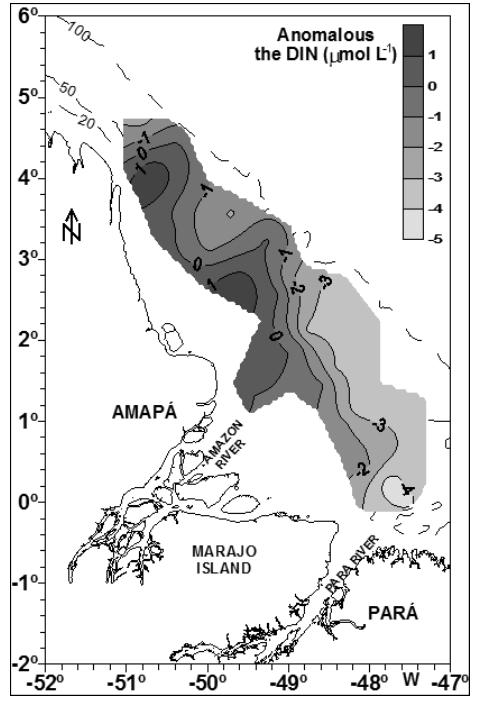
Fig. 6 – Superficial distribution of the anomalous dissolved inorganic nitrogen data (DIN) during the Amazon’s falling discharge period at the Amazon Continental